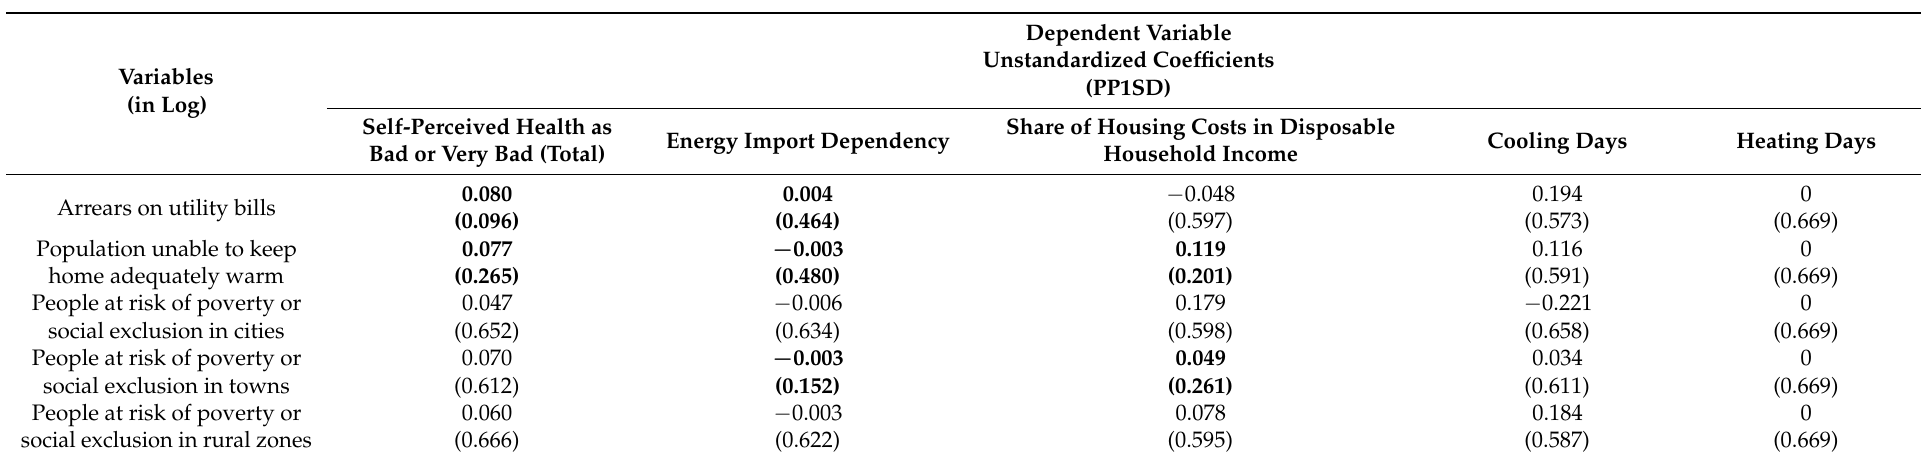
Table 11. The results of generalized ridge regressions for